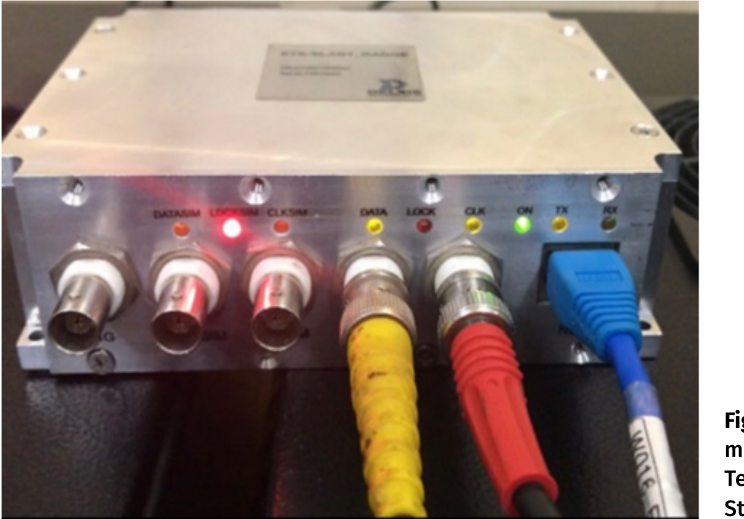
Figure 1. Slant Range device, used to measure the distance between the payload Telemetry Station and the Telemetry